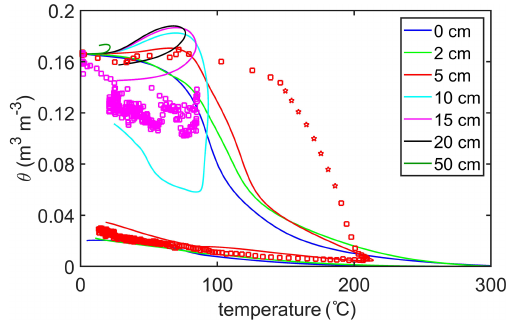
Figure 12. Modeled and observed θ − T trajectory. Observed data are denoted with symbols and modeling results are solid lines. The observed volumetric soil moisture has been temperature